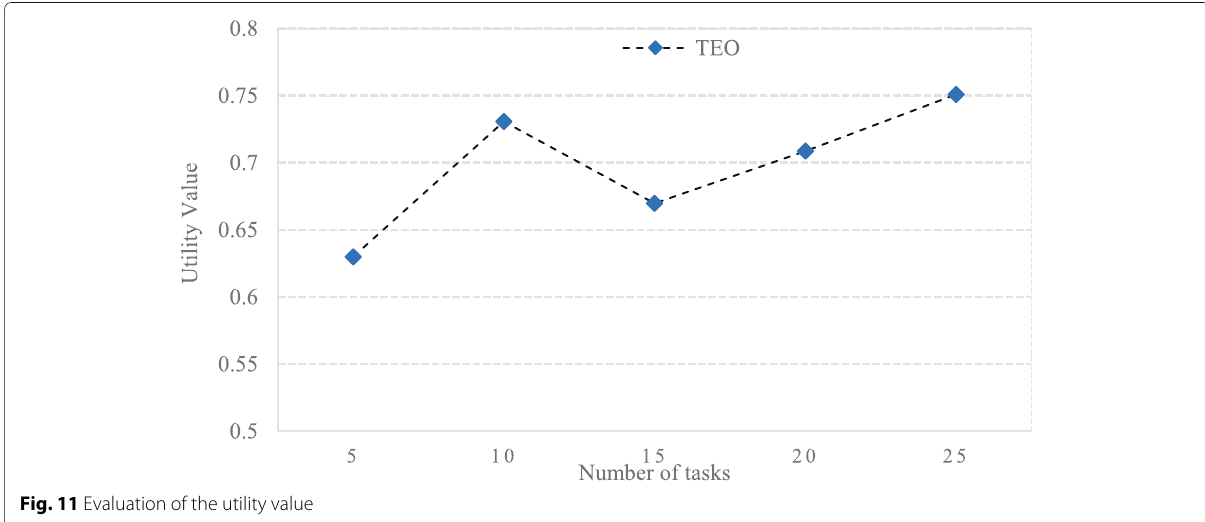
Fig. 11 Evaluation of the utility